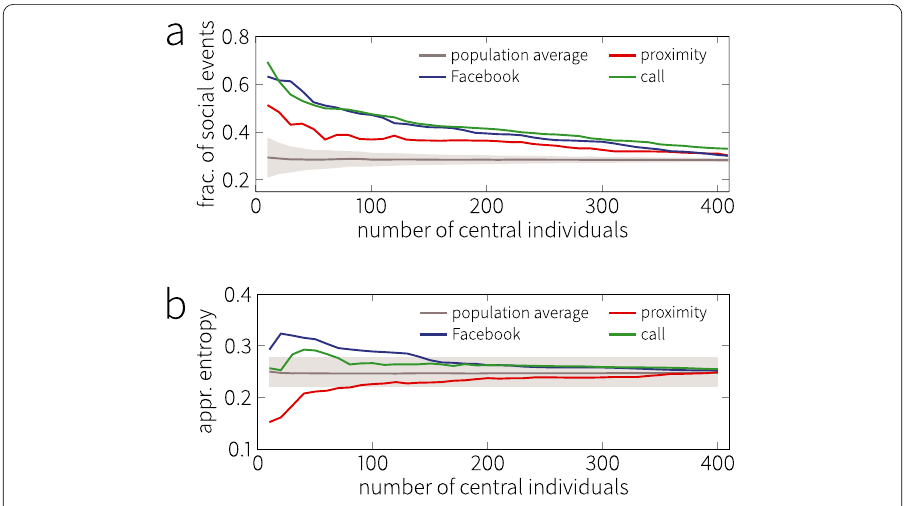
Figure 4 Activity during social hours and regularity of the social core and the proximity driven. (a) Median number of physical contact during social hours. (b) Approximate entropy of the contact activity. Grey line denotes the population median with error bands representing lower and upper quartiles. All data is calculated over a four month period between February and May